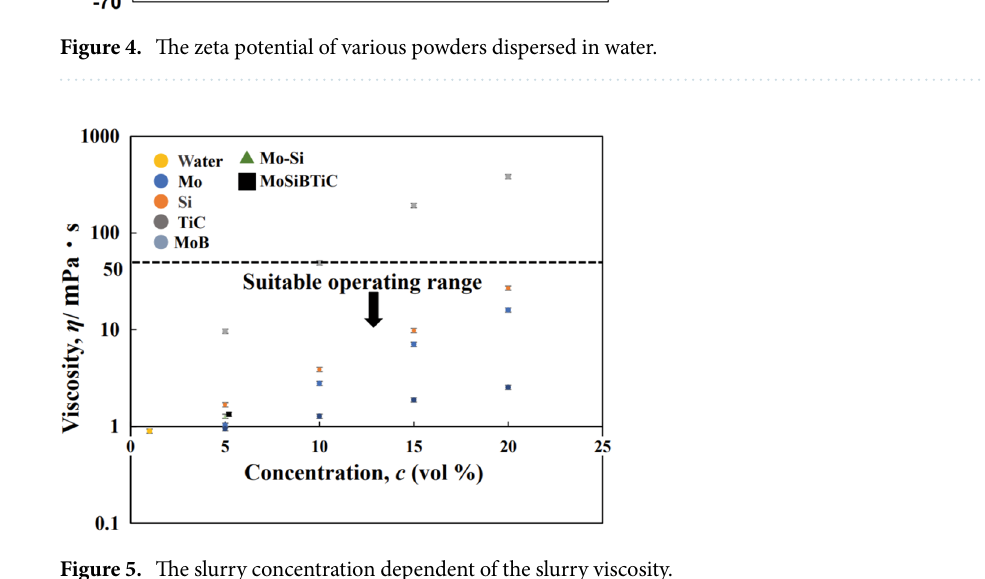
Figure 5. The slurry concentration dependent of the slurry